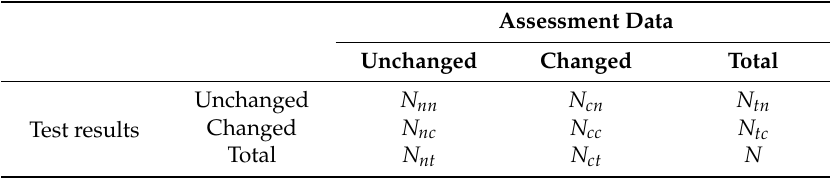
Table 4. Confusion matrix for land cover change